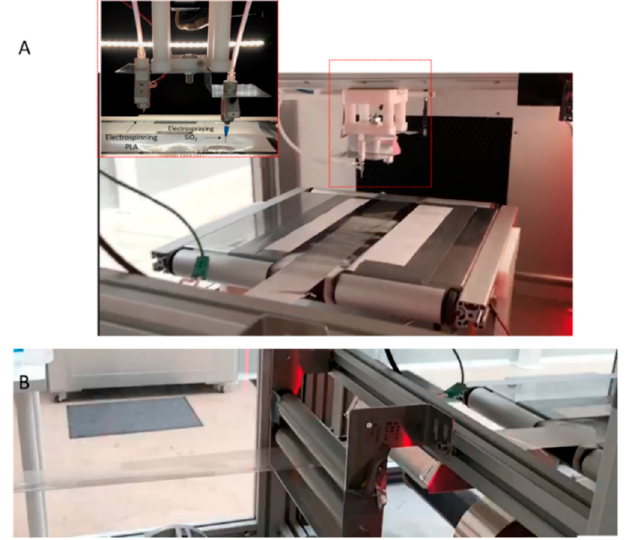
Figure 1. ( A ) Co-continuous electrospinning/electrospraying proprietary setup for the coating of the polyethylene terephthalate (PET) film by polylactide (PLA) fibers and silica (SiO 2 ) microparticles including an amplified image of the injector. ( B ) The roll containing the non-coated PET moving continuously from the area of the injector (for the deposition of fibers and microparticles) to the end of the roll collector, where it was collected in a coil-like manner.